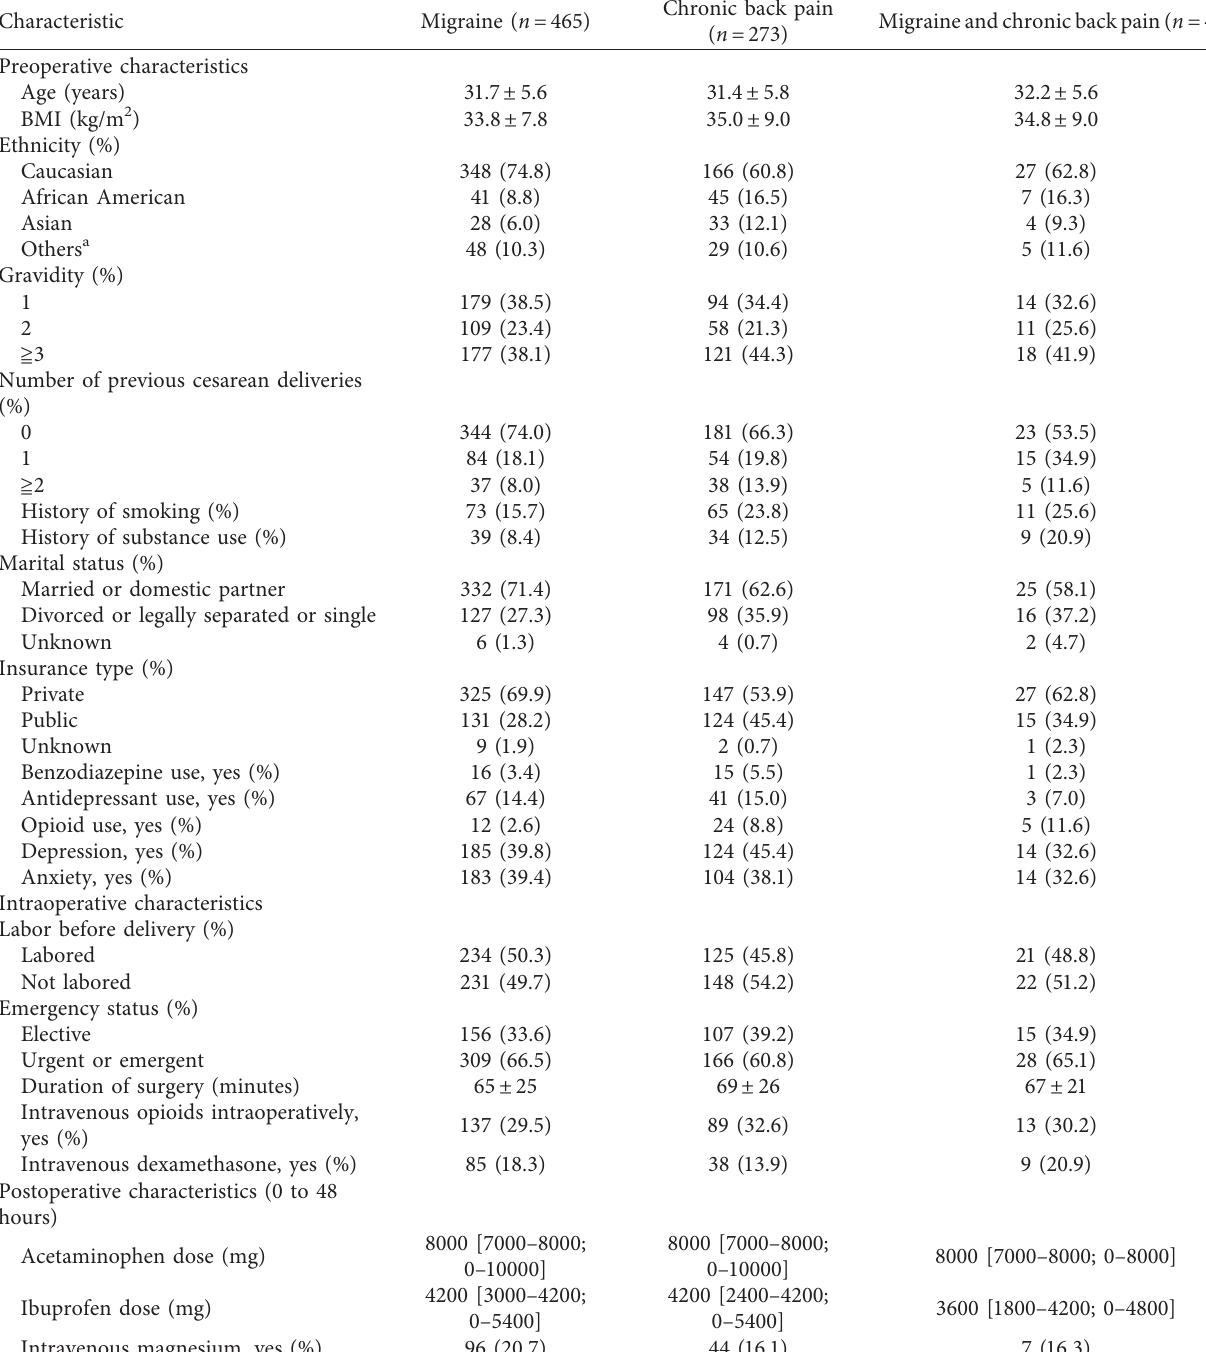
Table 1: Demographic, obstetric, intraoperative, and postoperative